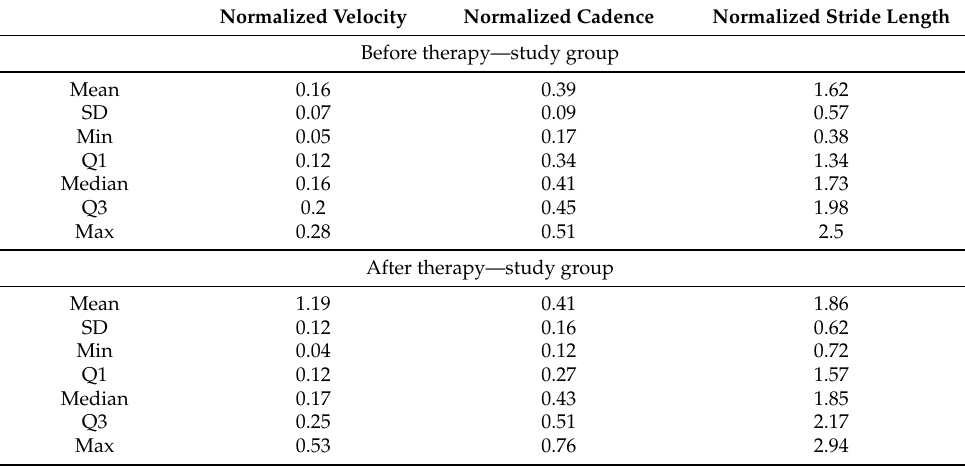
Table 2. Results for the study and reference